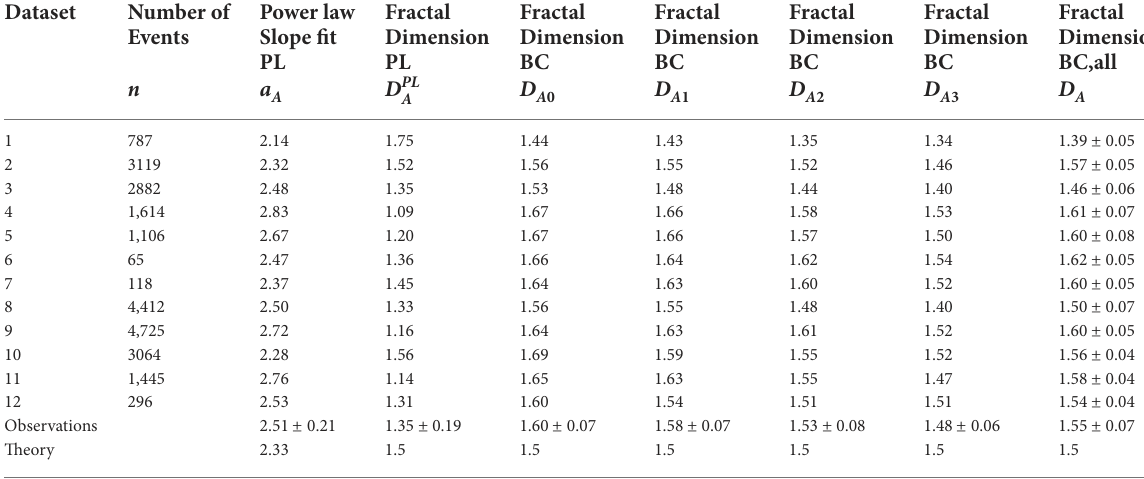
TABLE 1 FractalDimensionobtainedfrompowerlawslopefits(PL)andfromtheboxcounting(BC)methodfor12IRISdatasets. Dataset